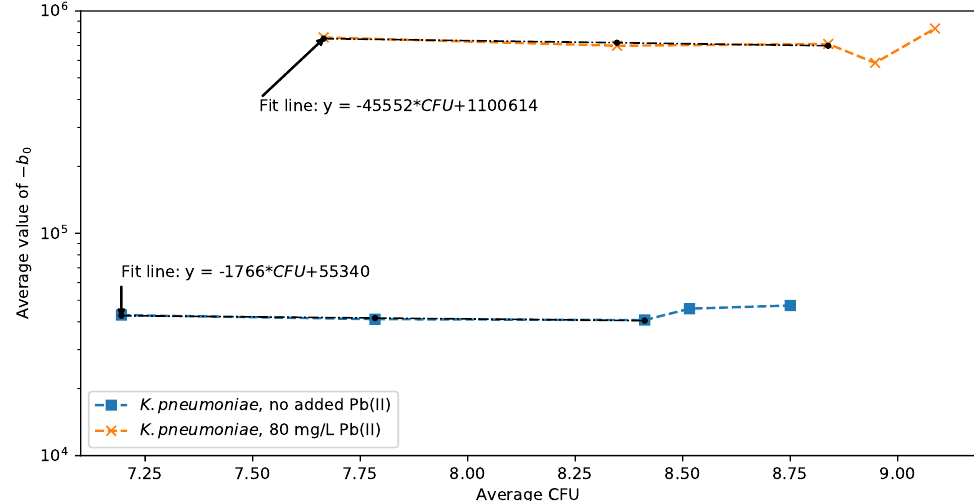
Figure 9. Changes in the supercapacitor b 0 for K. pneumoniae with and without Pb(II).